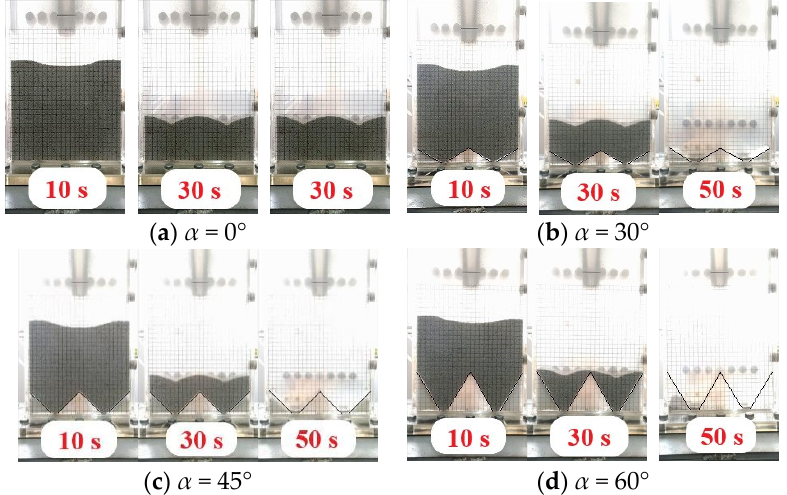
Figure 6. Particle flow pattern under different cone angles.